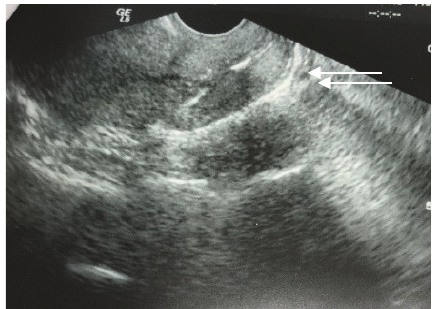
Figure 1: Ultrasound showing a hyperechoic cervix.